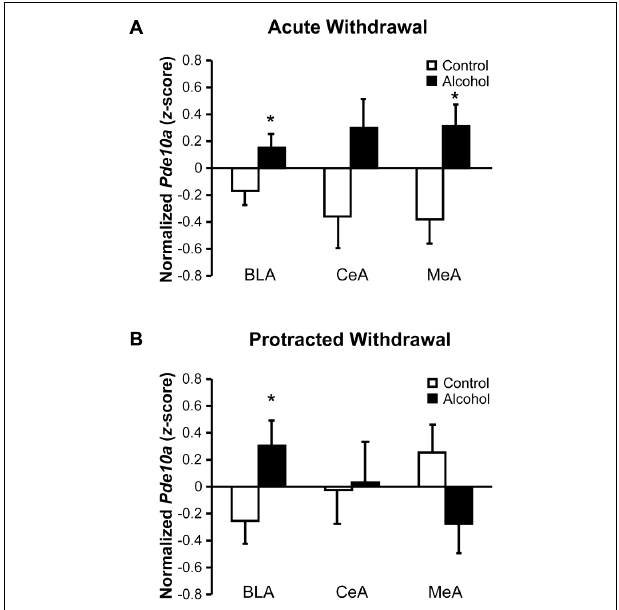
FIGURE 2 |Acute and protracted alcohol withdrawal generated lasting increases in Pde10a mRNA expression in the basolateral amygdala, but opposite profiles in the medial amygdala. (A) Acute (8–10 h) withdrawal from intermittent alcohol vapor (black bars) exposure significantly increased Pde10a mRNA levels in the basolateral (BLA) and medial (MeA) nuclei of the amygdala, without significant alteration in the central nucleus (CeA), relative to alcohol-naïve control rats (white bars). (B) Pde10a mRNA levels remained elevated in the BLA 6 weeks later, during protracted withdrawal, while expression levels tended to be decreased in the MeA. No significant difference between control and alcohol-withdrawn rats was observed in the CeA. Data are presented as least squares means ± standard error of z -score transformed Pde10a , covaried for Cyp expression levels. * p < 0.05 vs. Control; n = 8–12 per group.